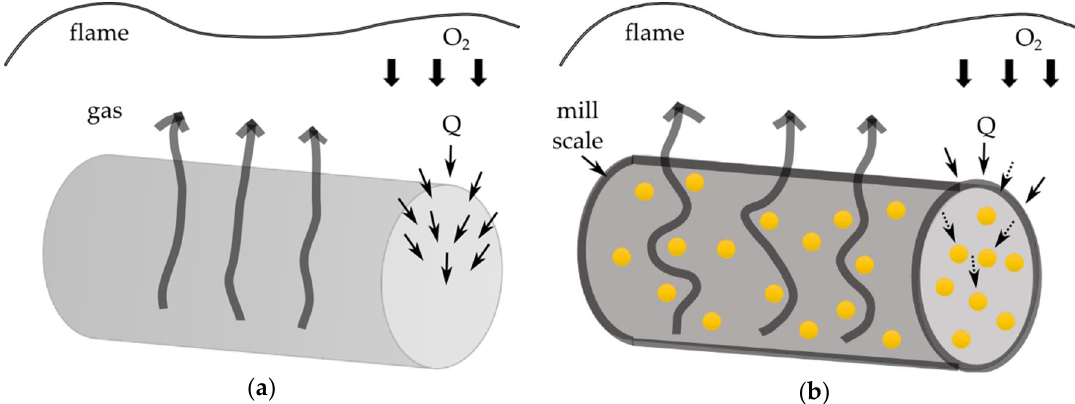
Figure 12. Flammability diagram of fibers: a) undoped; b) with AgNPs.